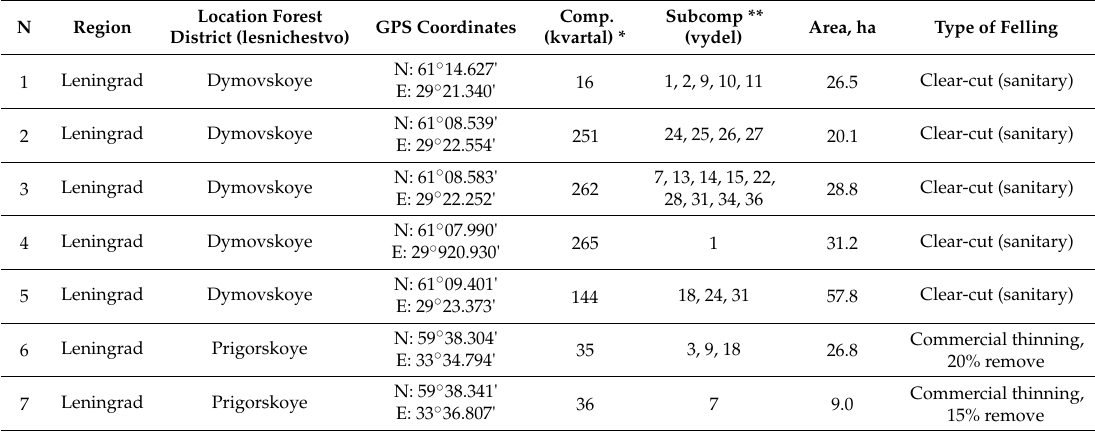
Table 5. Forest site audits at the forest management unit